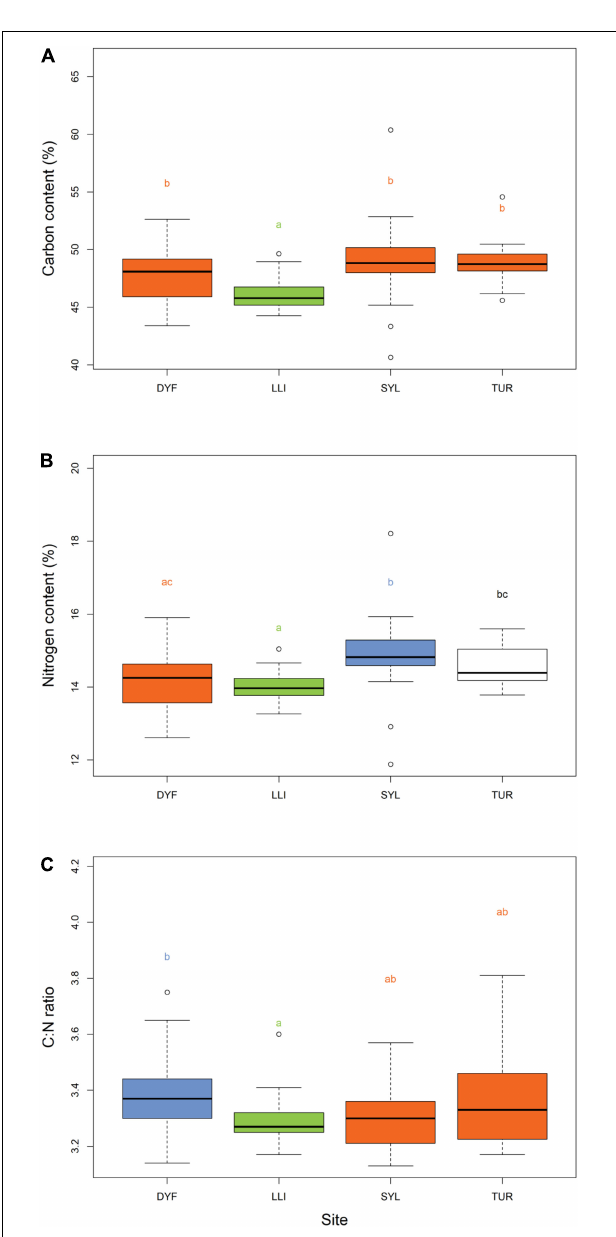
FIGURE 4 | Variation in (A) % carbon content, (B) % nitrogen content, and (C) C:N ratios of topmouth gudgeon across study sites. Sites that have different colors and letter subscripts are statistically different from each other following Tukey’s HSD post-hoc pairwise